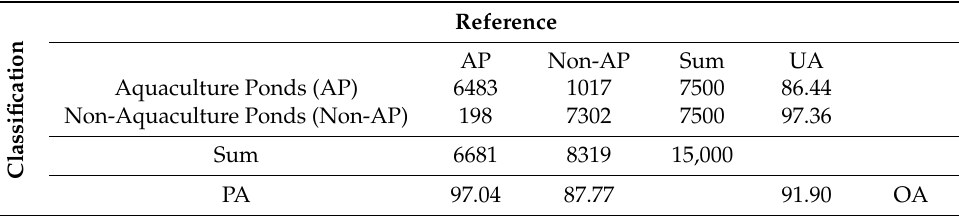
Table 4. Accuracy assessment for the two classes of aquaculture and non-aquaculture for the